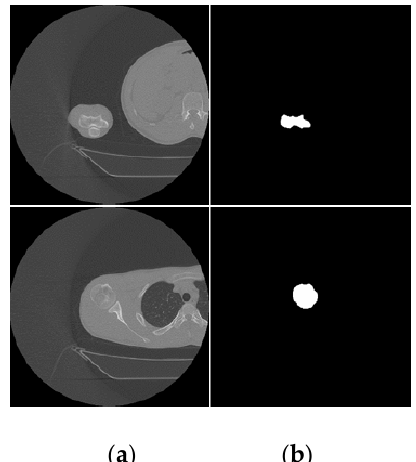
Figure 2. Manual segmentation of the humerus from shoulder CT image: ( a ) CT image and ( b ) corresponding humeral region.